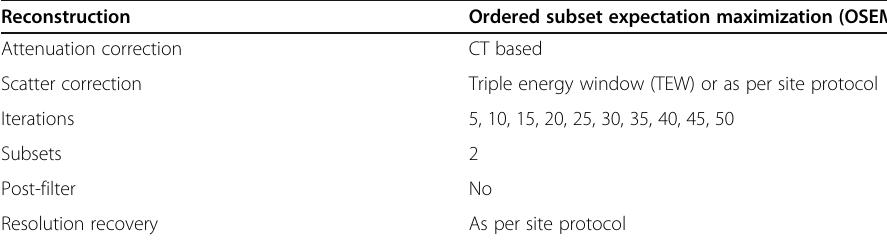
Table 4 SPECT/CT reconstruction